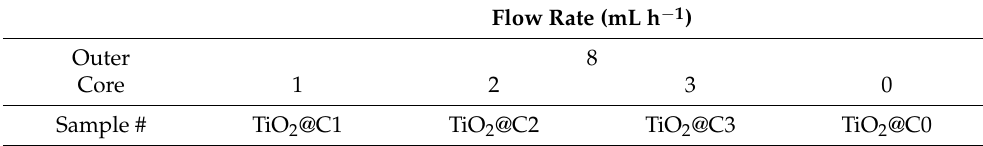
Table 1. Electrospinning conditions and sample codes of hollow and solid (non-hollow) TiO 2